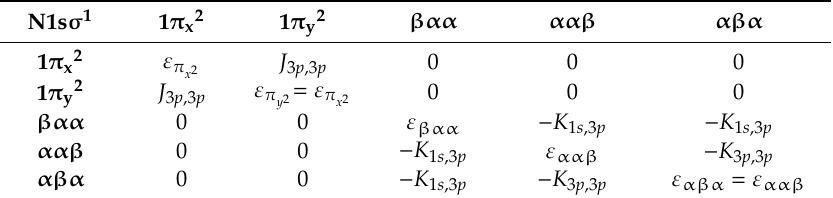
Table 4. Diagonal ( ε ) and sub-diagonal coupling matrix elements between the N1s σ 1 1 π xa 1 π yb (a = 0 or 1; b = 0 or 1) configurations. β and α denote spin configurations. For example, βαα means N 1 s 1 π 1 x π 1 y . J is a Coulomb matrix element. K is a (positive) exchange matrix